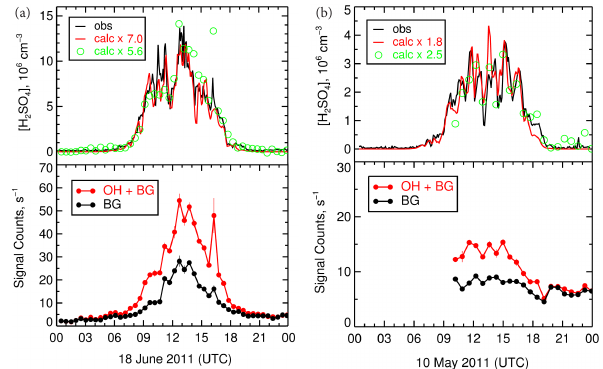
Figure 5. (a) Example of observed ambient H 2 SO 4 concentration in comparison with H 2 SO 4 mass balance values calculated from Eq. (1) for 18 June 2011. Air masses originated from polar regions between Greenland and Iceland, exhibiting strong biological activ- ity in surface waters. As OH had only been measured for 5min during each half-hour period, to obtain calculated H 2 SO 4 for each of the corresponding measured H 2 SO 4 values we used J (O 1 D) as a proxy for OH to fill the corresponding gaps based on the OH- J (O 1 D) relation established for the marine sector (Berresheim et al., 2013) (continuous 5min time resolution). Top: mean discrep- ancy factor of 7.0 between midday (10:00–14:00UTC) observed and calculated [H 2 SO 4 ]. Open symbols show calculated [H 2 SO 4 ] based on actual OH measurement signals (ratio: 5.6 ± 1.2). Bottom: signal counts obtained for OH measurement (OH plus background) and background mode only (cycle: 5min during each 30min pe- riod). (b) Example of relatively small discrepancy between mea- sured and calculated H 2 SO 4 based on Eq. (1) (ratio 1.8) and actual OH measurements (ratio 2.5 ± 1.2), respectively. With one excep- tion, nighttime OH values were all below the detection limit. For further explanations see caption (a) and the main text. Air mass ori- gin was mainly from the temperate North Atlantic in connection with anticyclonic